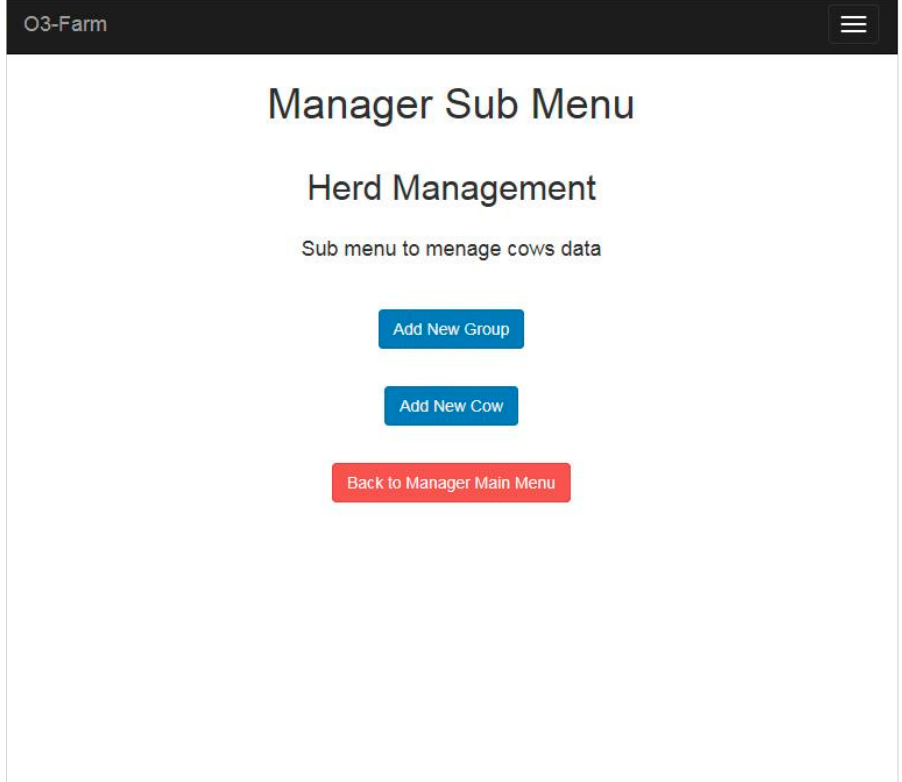
Figure 6. Herd management sub-menu available for managers to add a cow or a new group of animals.